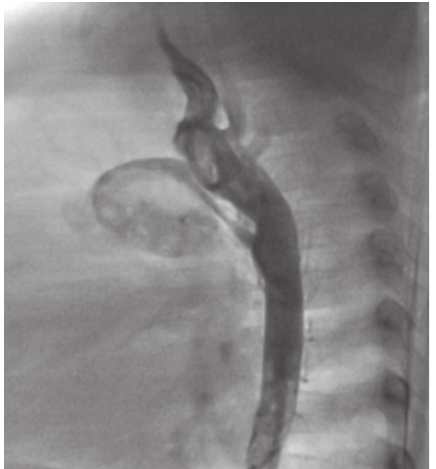
Figure 2: Lateral angiogram showing severe neointimal prolifer- ation inside the stent, especially at its pulmonary